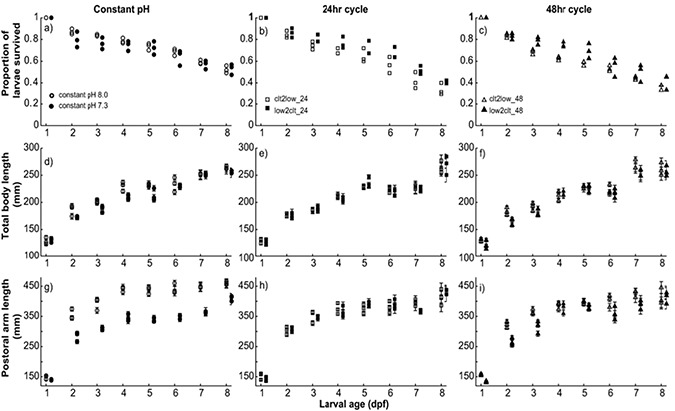
Larval survival decreased under constant pH 8.0, constant pH 7.3 and fluctuating pH between these two levels over 8 days post fertilization (dpf). Each symbol represents the raw count observed within one replicate jar (a–c). Linear regressions between the observed proportions and time were used to determine the mortality rate (Table S1). Larval growth rate was determined by measuring the total body length (d–f) and postoral arm length (g–i) of 15 haphazardly selected individuals from each treatment daily. Means and standard error of means for each replicate jar were plotted for d–i. Logarithmic regressions between the body/arm length and time were used to determine the growth rate (Table S1). Open symbols represent treatments that started with control (pH 8.0) condition, and solid symbols are for those starting with pH 7.3.